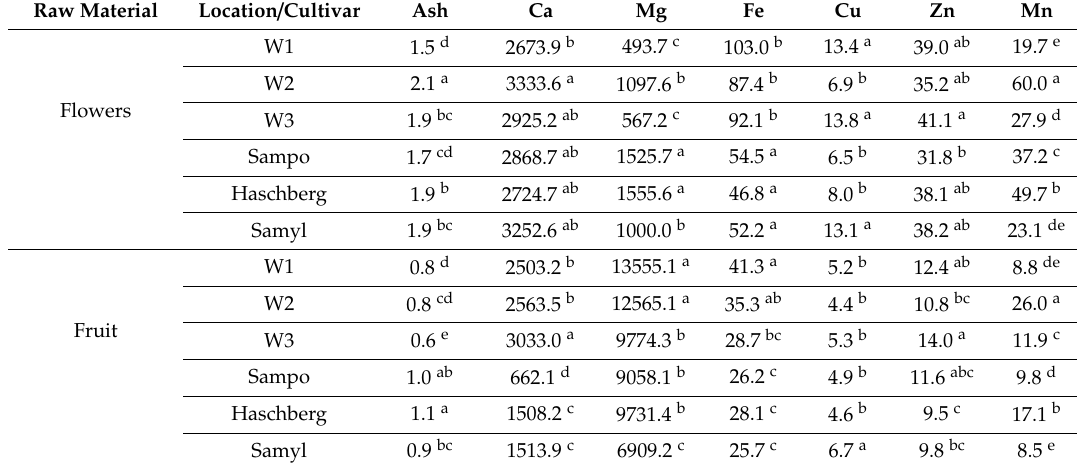
Table 1. The content of ash (%) and selected minerals ( µ g / g d.m.) in elderberry flowers and fruit, depending on the location (wild plants) and cultivar.